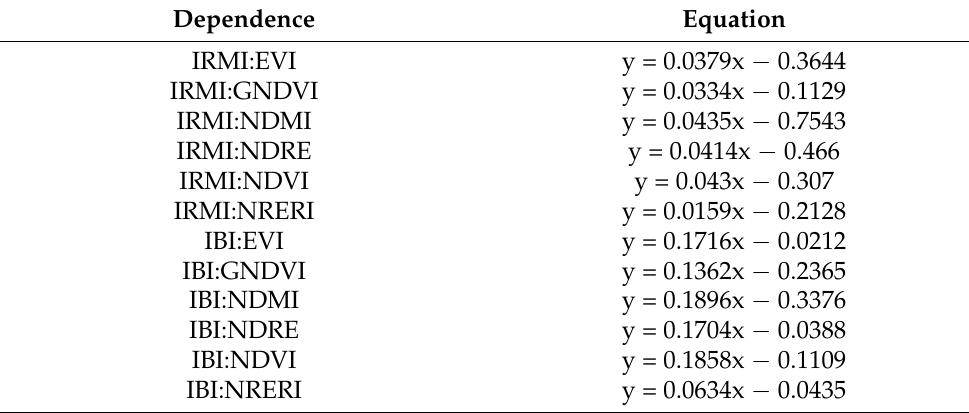
Legend: Red-marked Spearman’s correlation coefficients indicate a significant relationship between IBI and other vegetation indices. The strength of this relationship is indicated using colors, the red color of the cells indicates a weak relationship, orange and yellow indicate a moderate relationship and green indicates a strong relationship. Table 7. Regression equation of linear